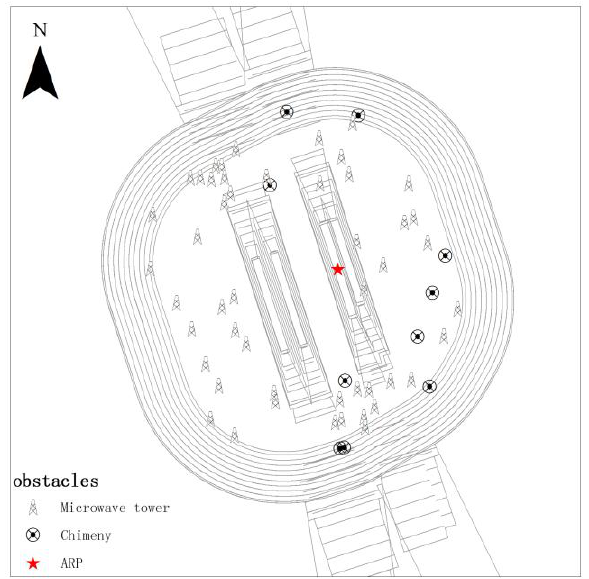
Figure 6. Obstacle topographic map